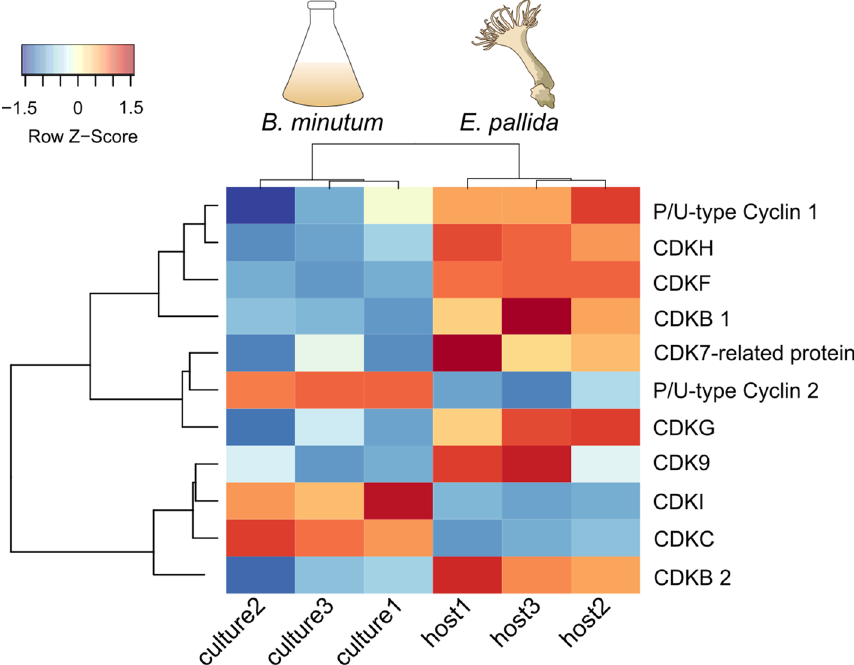
Figure 3. Heat map comparison of Breviolum minutum cyclin and CDK gene expression between culture and cells freshly isolated from Exaiptasia pallida . Red corresponds to a higher Z-score and gene up-regulation whilst blue corresponds to a lower Z-score and down-regulation.